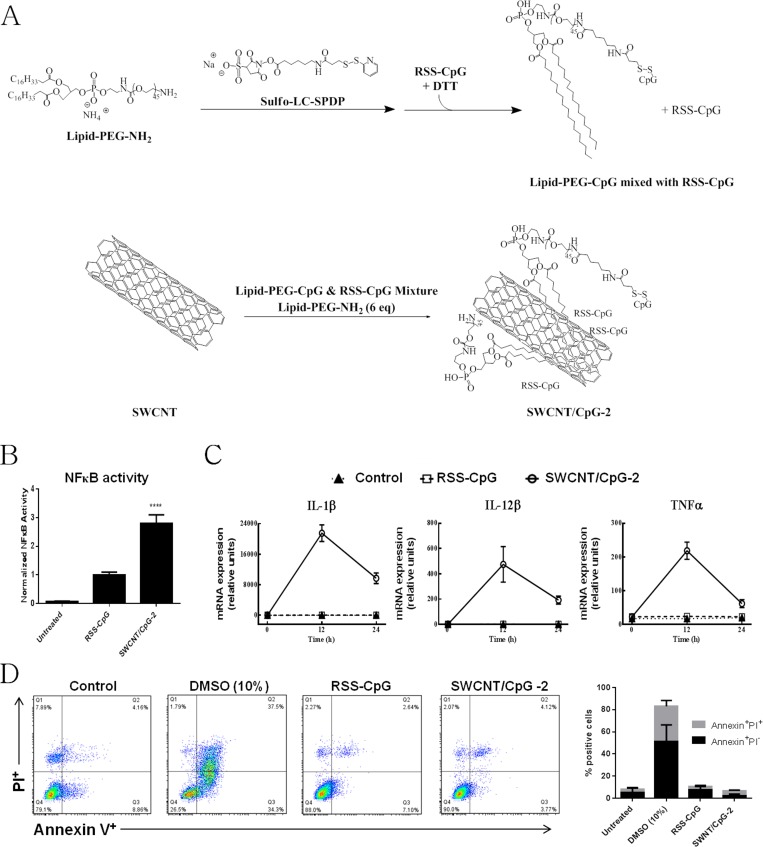
Synthesis and in vitro activity of the SWCNT/CpG-2.(A) Schematic drawing of the SWCNT/CpG-2 synthesis. RSS-CpG was reacted with Lipid-PEG-NH2 prior to the dispersion of SWCNTs. (B) NFκB activity of RSS-CpG (10 μg/mL), and SWCNT/CpG-2 (10 μg/mL) compared to untreated RAW-Blue™ macrophages. SWCNT/CpG-2 treatment induces a significant increase in NFκB activity when compared to RSS-CpG treatment (Student’s t-test, **** P < 0.0001, n = 6). (C) Real-Time PCR analysis of pro-inflammatory cytokines in human peripheral blood mononuclear cells (PBMCs) incubated with RSS-CpG (1 μg/mL) or SWCNT/CpG-2 (1 μg/mL). (D) Cell toxicity was measured by the Annexin V/PI apoptosis assay. This assay detects cell populations that are indicative of cytotoxicity: apoptotic cells (Annexin+ PI-, bottom right quadrant of flow plot) and necrotic cells (Annexin+ PI+, top right quadrant). Raw-Blue™ cells were incubated with SWCNT/CpG-2 (10 μg/mL), RSS-CpG (10 μg/mL) or PBS for 12 hours prior to Annexin V and PI labeling. As a negative control, cells were treated with 10% DMSO in order to induce cell death. Representative flow cytometry analysis (left panel), and a stacked bar chart showing the proportion of both apoptotic and secondary necrotic cells (right panel) (n = 3).